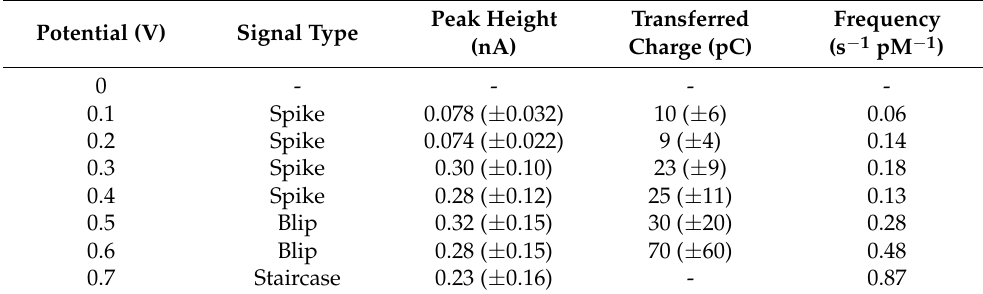
Table 1. Analysis of the current signal of a single Ag NP